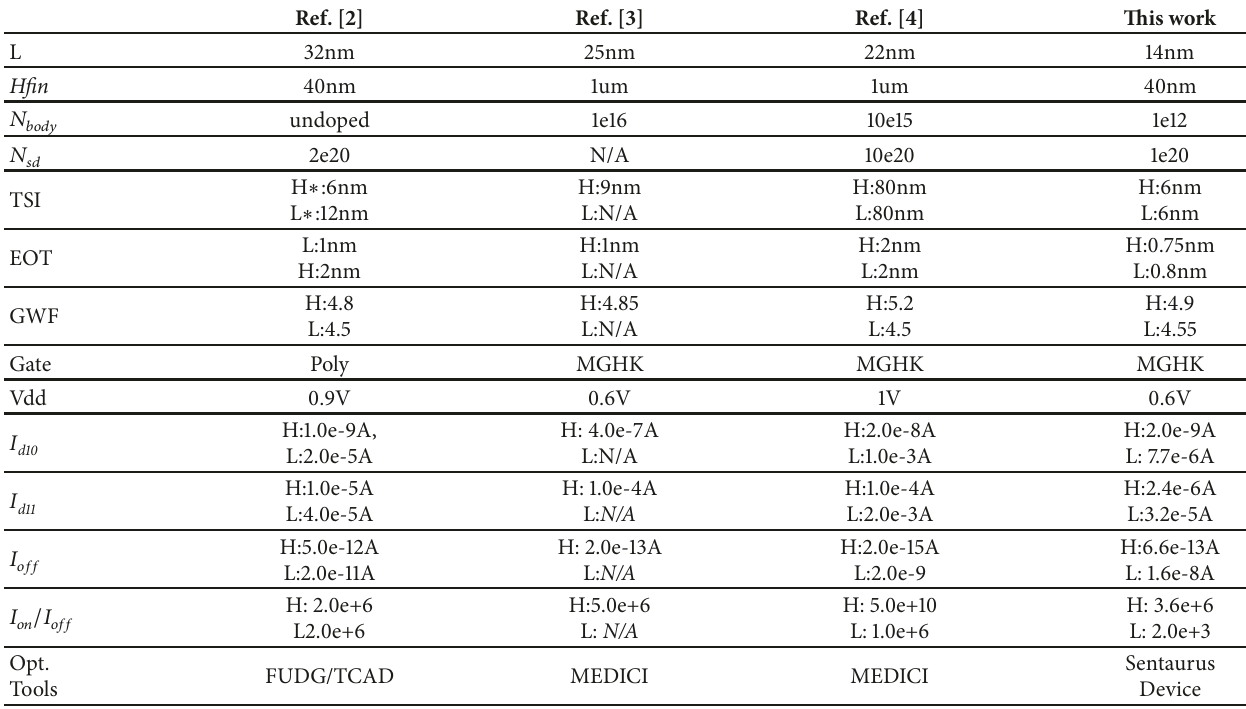
Table 1: Comparison with previous works.